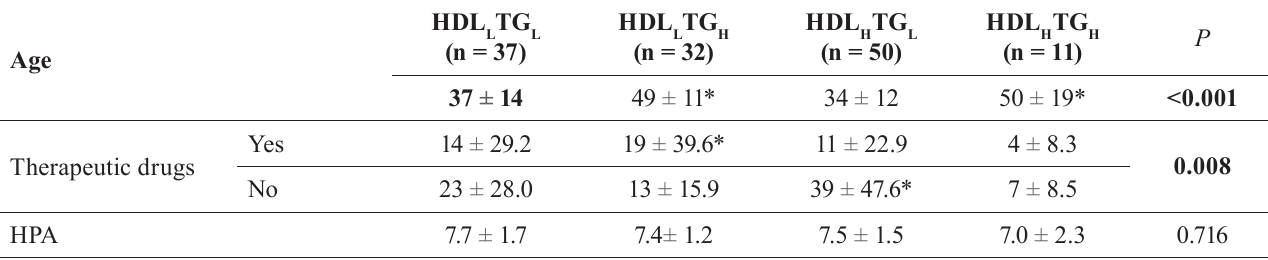
TABLE I - D emographic and clinical profile of subjects